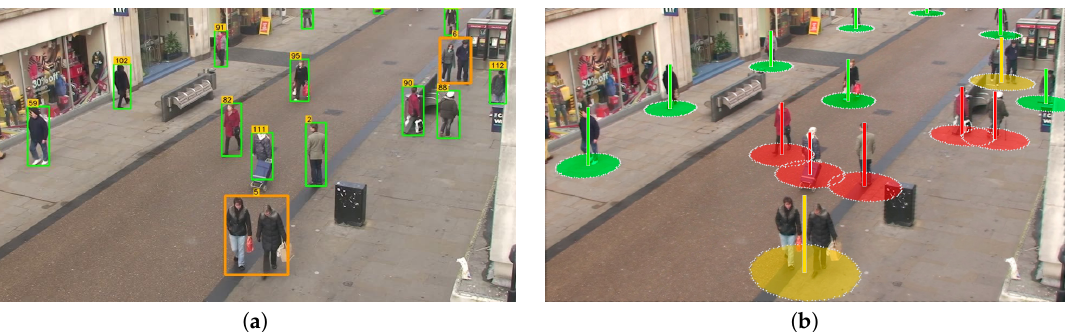
Figure 14. Social distancing violation detection for coupled people and individuals. ( a ) Examples of coupled people detections-orange bounding boxes; ( b ) Three types of detections: safe, violations, coupled.